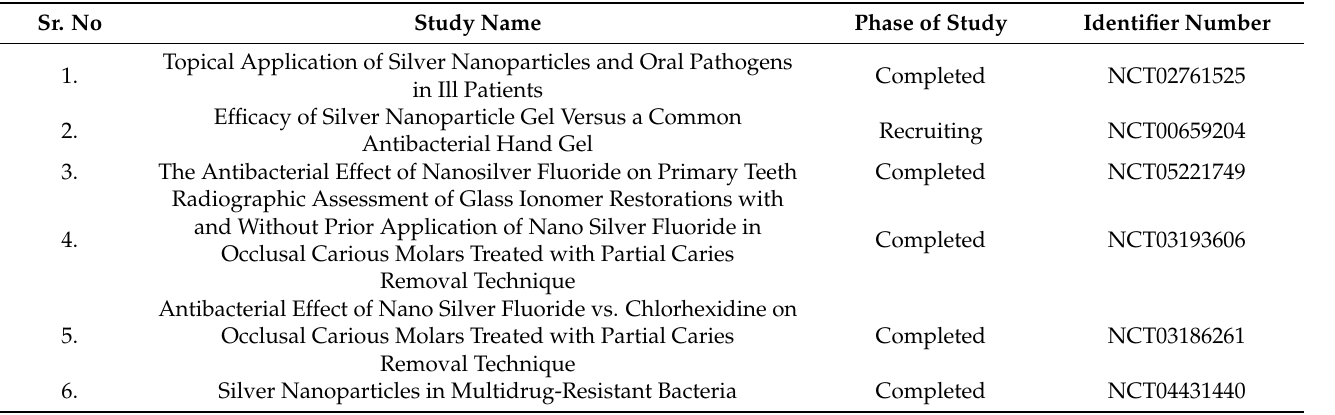
Table 3. Different studies under the clinical trial phase (Clinical trials.gov).